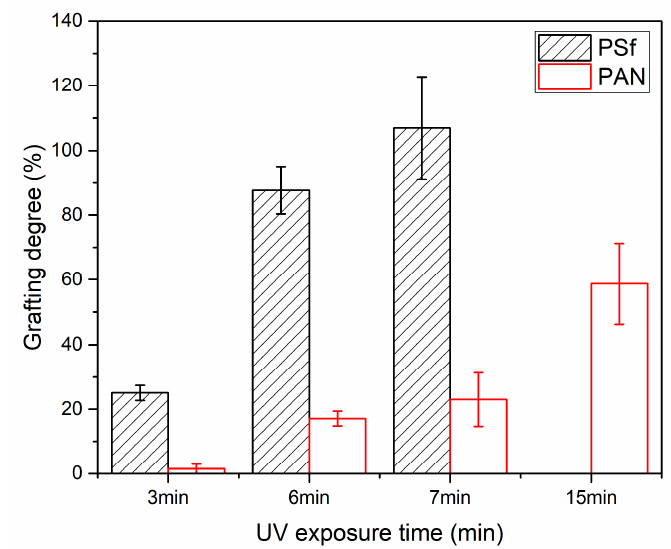
Figure 5. Grafting degree as a function of UV polymerization time for both electrospun PSf and PAN membranes.